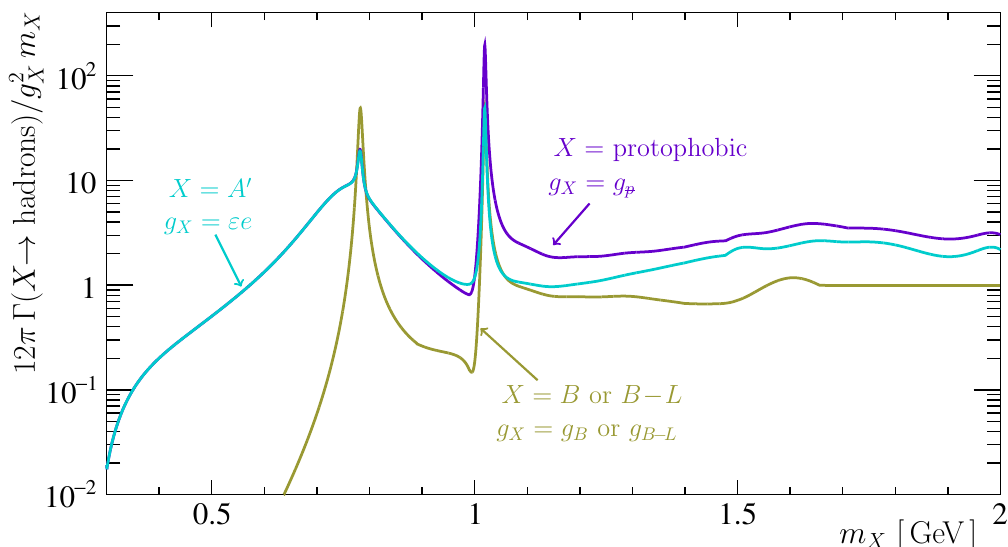
Figure 9 . Hadronic decay width for: a dark photon, where g X = "e ; a gauged B where g X = g B or g B (cid:0) L ; and a protophobic boson, where g X = g p .